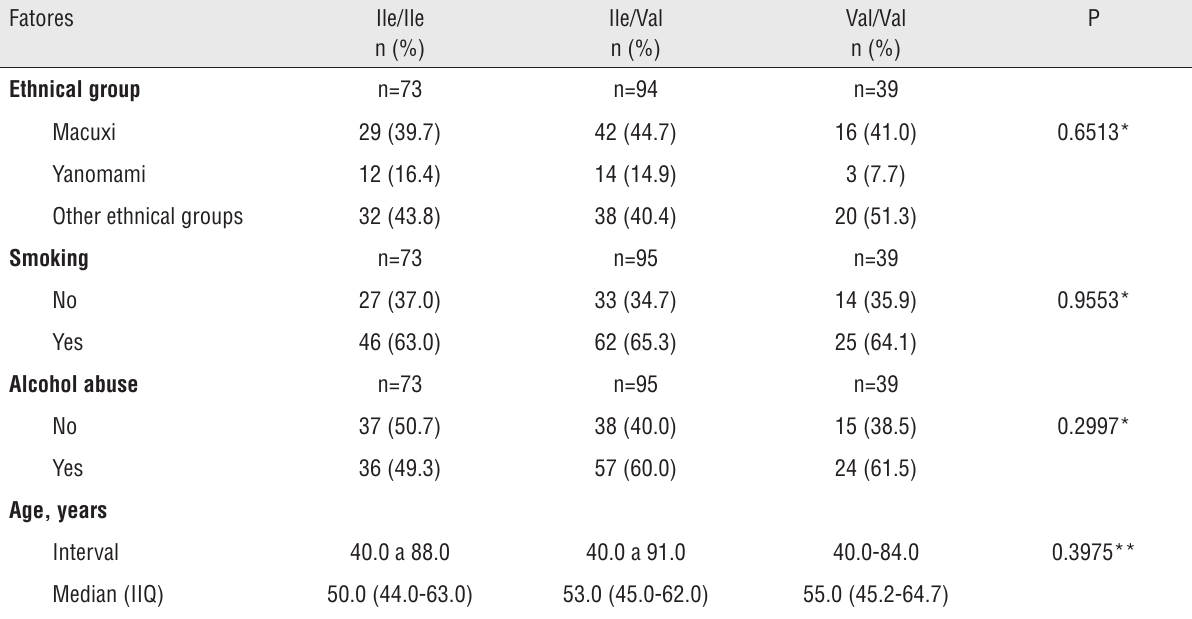
Table 6 - Demographic and clinical characteristic, according to GSTP1 variant.